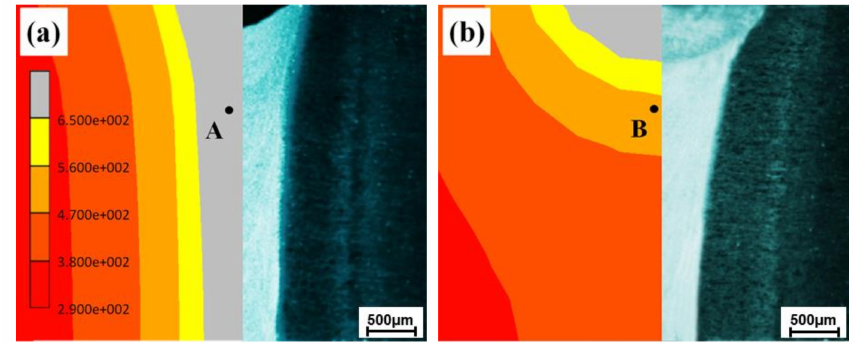
Figure 9. Comparison between simulated molten pool and experimental weld morphology: ( a ) without modification welding and ( b ) with modification welding.